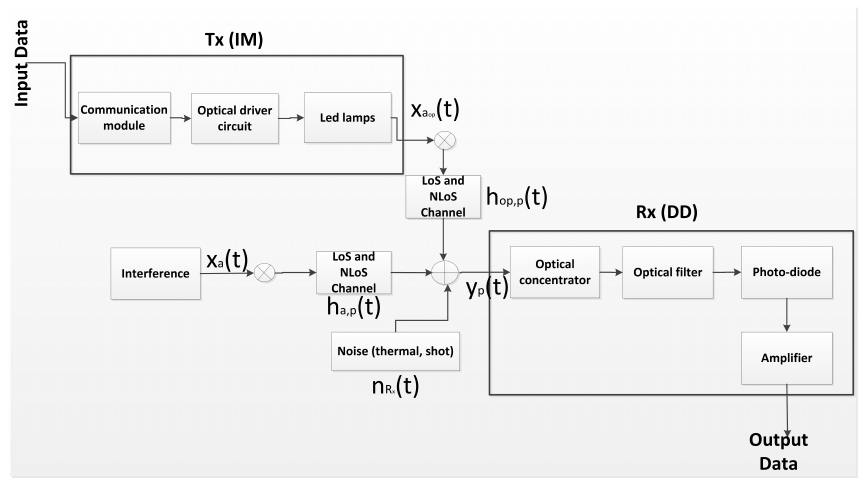
Figure 3. Block diagram of the underground mining VLC